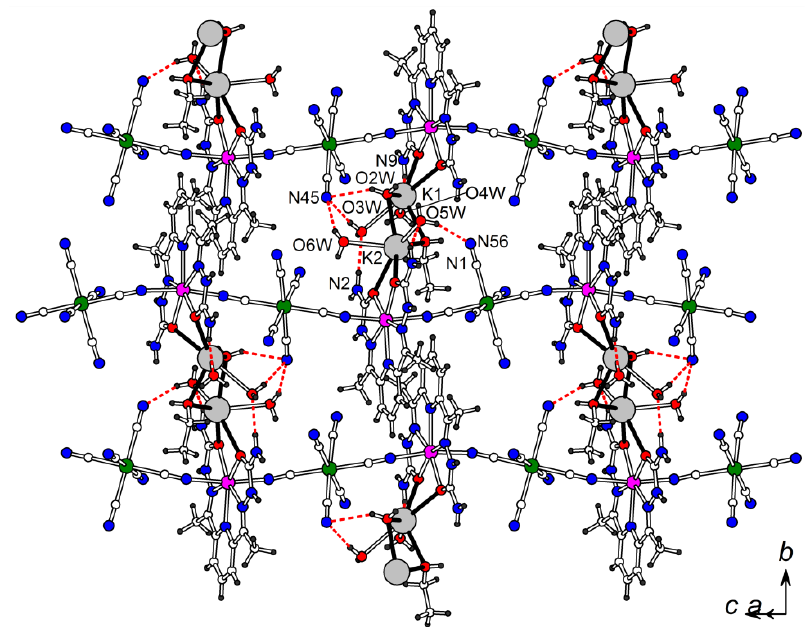
Figure 2. Infinite CN-bridged {[M II (H 2 dapsc)] 2+ [Cr III (CN) 6 ] 3 − } n chains in 1 interacting by π - π stacking of H 2 dapsc ligands and coordination bonds via K + /O in the (1 0 –1) plane. Interchain coordination bonds via pairs of K + cations are shown by black bonds. Hydrogen bonds are shown by red dashed lines (see Tables S1 and S2 for hydrogen bond geometry in 1 and 2 , respectively).